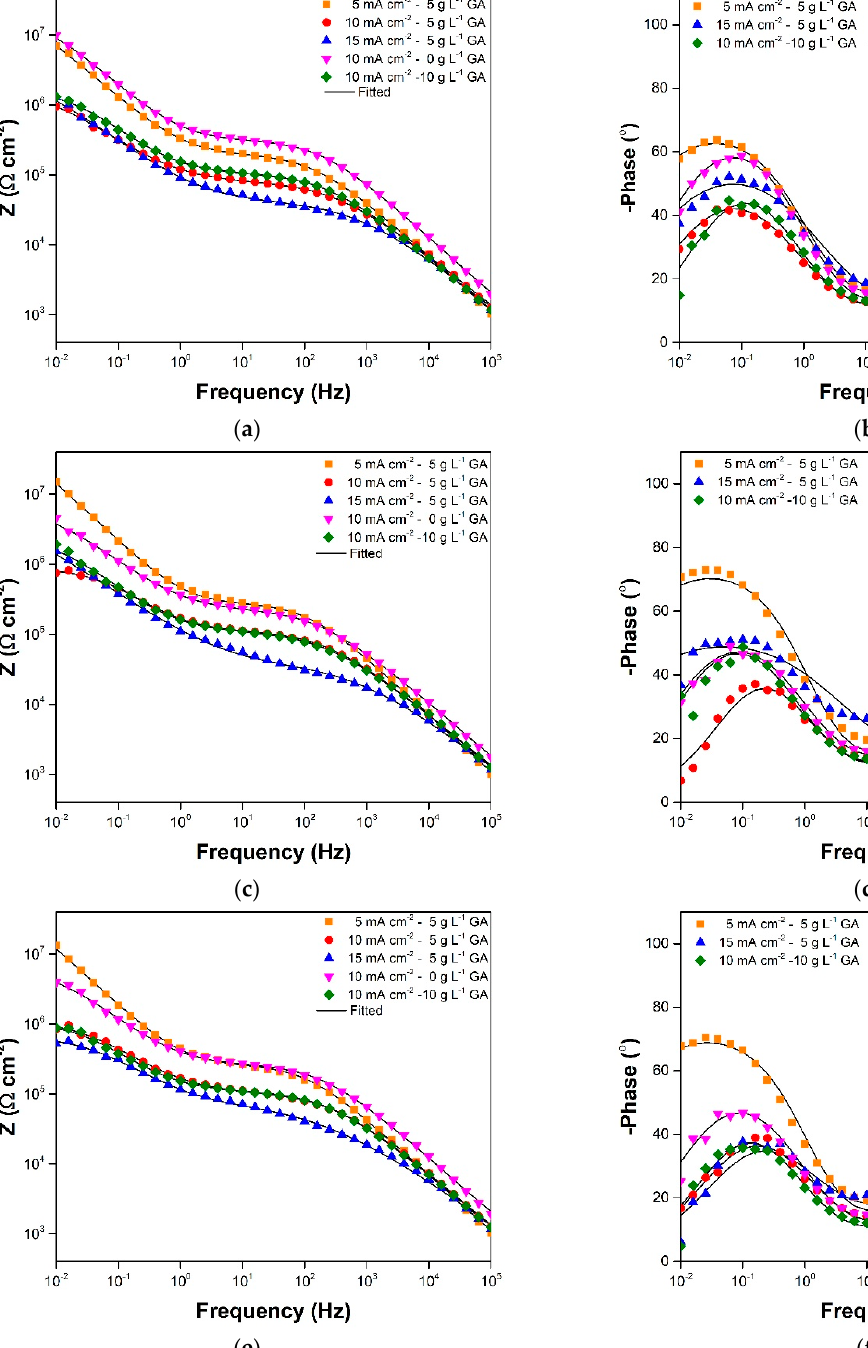
Figure 4. Bode-modulus and Bode-phase plots at ( a , b ) 3-day; ( c , d ) 7-day; and ( e , f ) 10-day immersion in 3.5 wt.% NaCl maintained in ambient conditions.